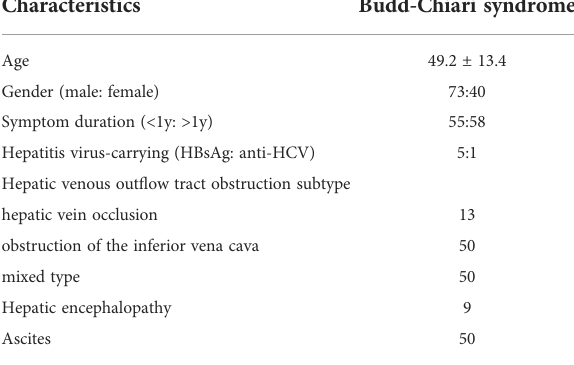
TABLE 1 Clinical data of 113 cases diagnosed with Budd-Chiari syndrome.